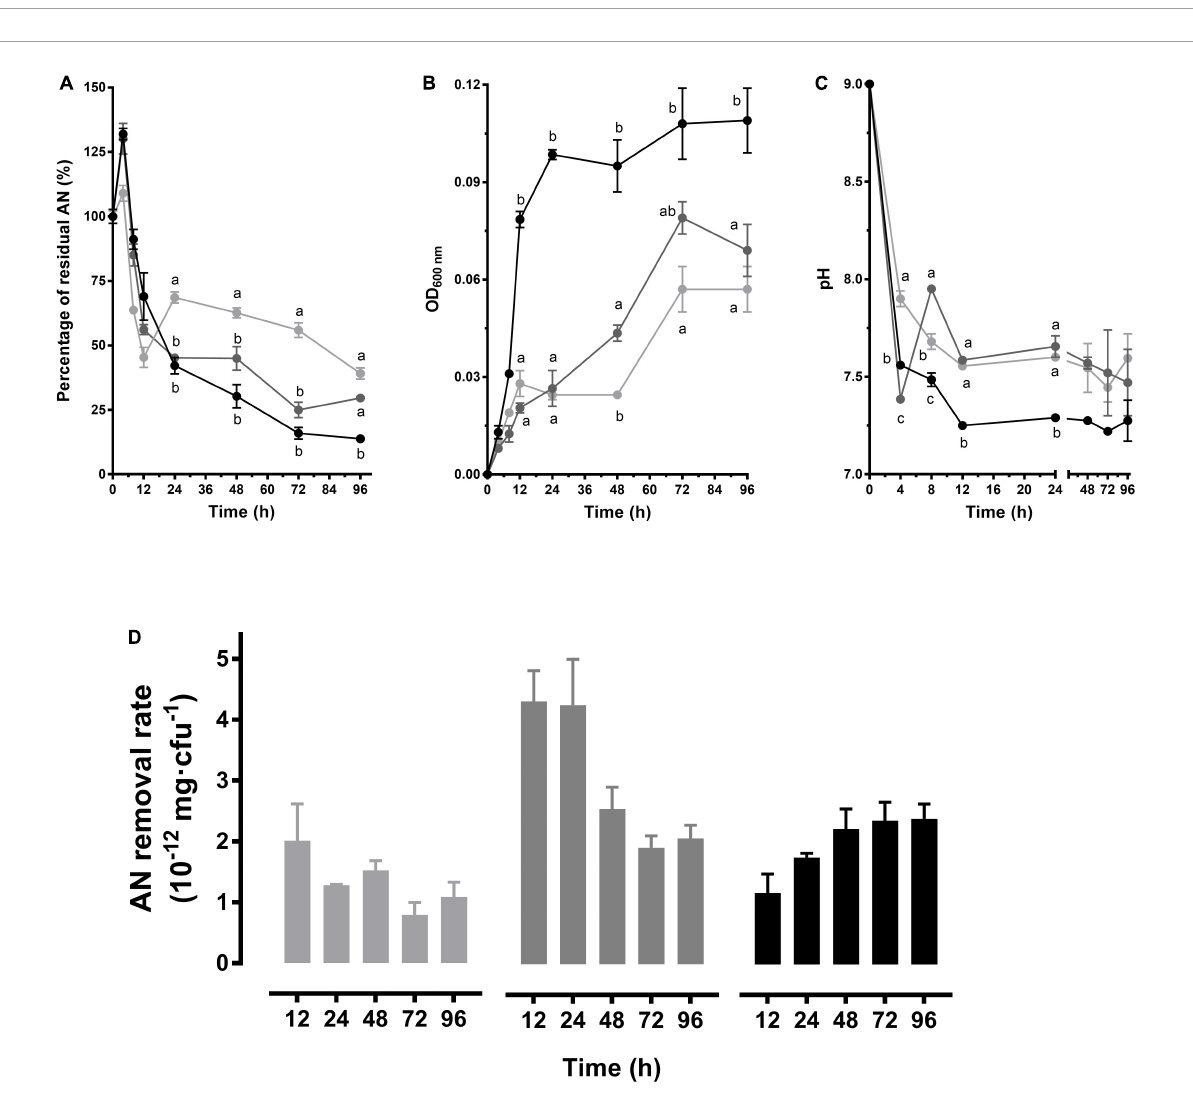
FIGURE2 AN removal characteristics of B. idriensis CT-WN-B3. The residual AN percentage (A) , OD 600 nm (B) , and pH (C) determined within 96 h were shown. Values of each time point with different superscripts in (A–C) were significantly different ( P < 0.05). (D) The removal rate (AN quantity per cell) in 0–12 h, 0–24 h, ... , 0–96 h of incubation. In (A–D) , lines or column in light gray, dark gray, and black color, respectively, represents 1, 2, and 3 mg/L initial AN concentration